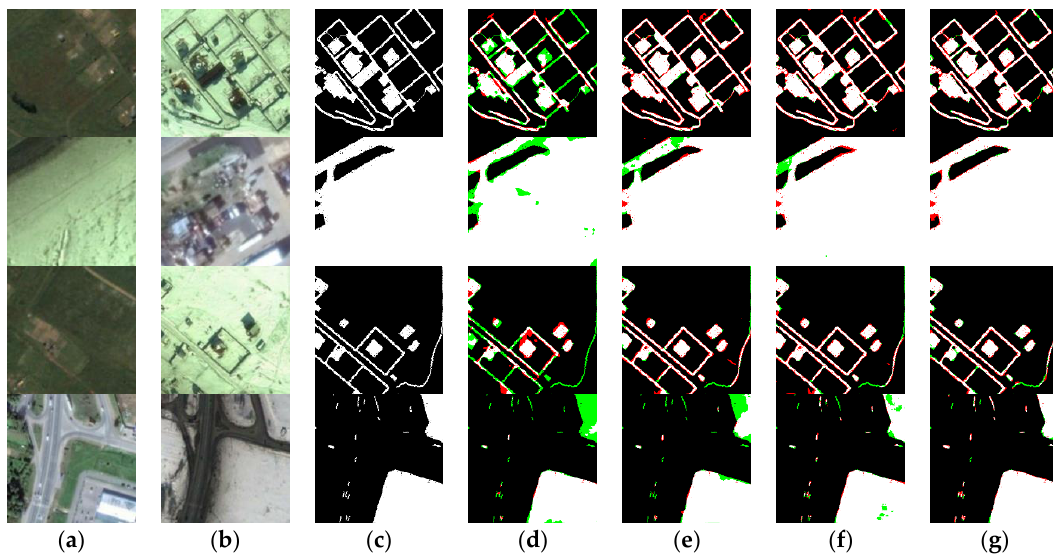
Figure 7. Visualization comparison results of different modules. ( a ) Image T1. ( b ) Image T2. ( c ) Ground truth. ( d ) Baseline. ( e ) Baseline with ASPCA module. ( f ) Baseline with CCR module. ( g ) Baseline with ASPCA and CCR modules. Each row represents the visualization ablation results of different validation sample pairs.